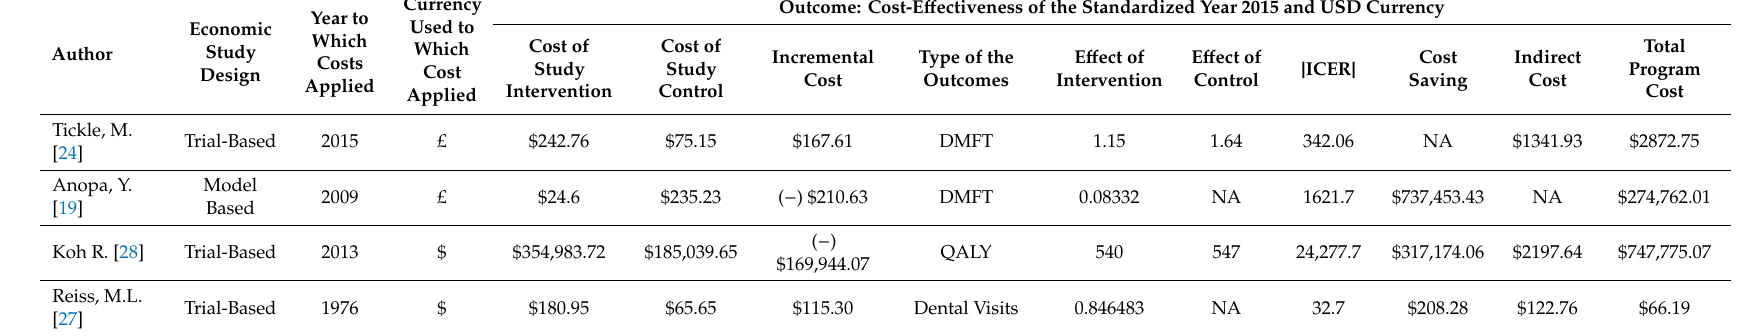
Table A2. Cost-E ff ectiveness Outcomes of the standardized included